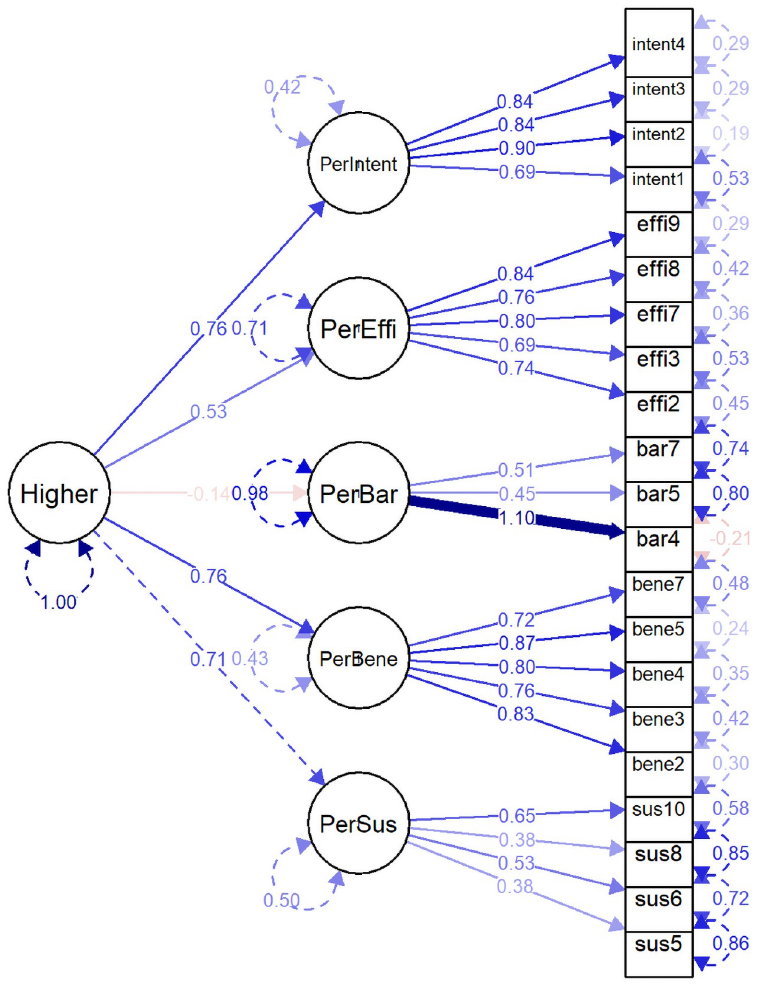
Fig 5. Perceived risk constructs of developing non-communicable diseases (Hierarchical model).